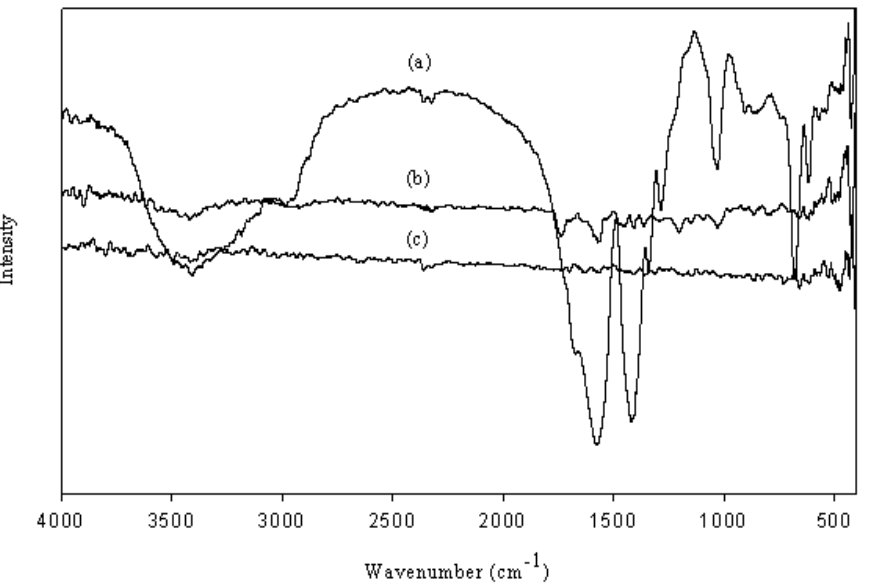
Figure 9. Fourier transform infrared spectrometer (FT-IR) spectra for: PVP/Ni acetate fiber mat ( a ), after calcination at 700 °C for 10 h ( b ), and after H 2 reduction at 400 °C for 1 h ( c ).